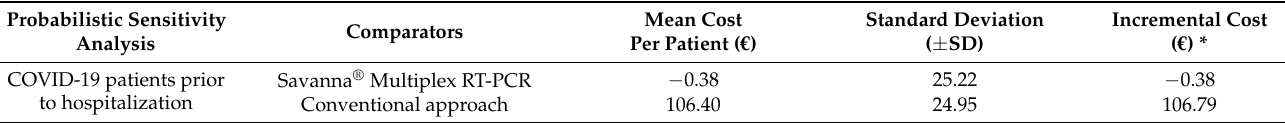
Table 4. Results of the probabilistic sensitivity analysis (Monte Carlo